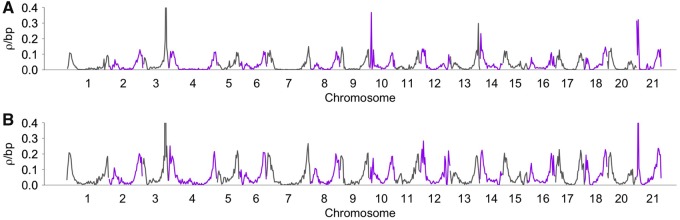
—Recombination rates are similar at a broad scale in each population. Mean recombination rates were estimated using LDHelmet in nonoverlapping 500-kb windows for each autosome in (A) Lake Washington and (B) Puget Sound. Centromere positions are shown in supplementary figures 6 and 7, Supplementary Material online. Transitions between gray and purple indicate different chromosomes.